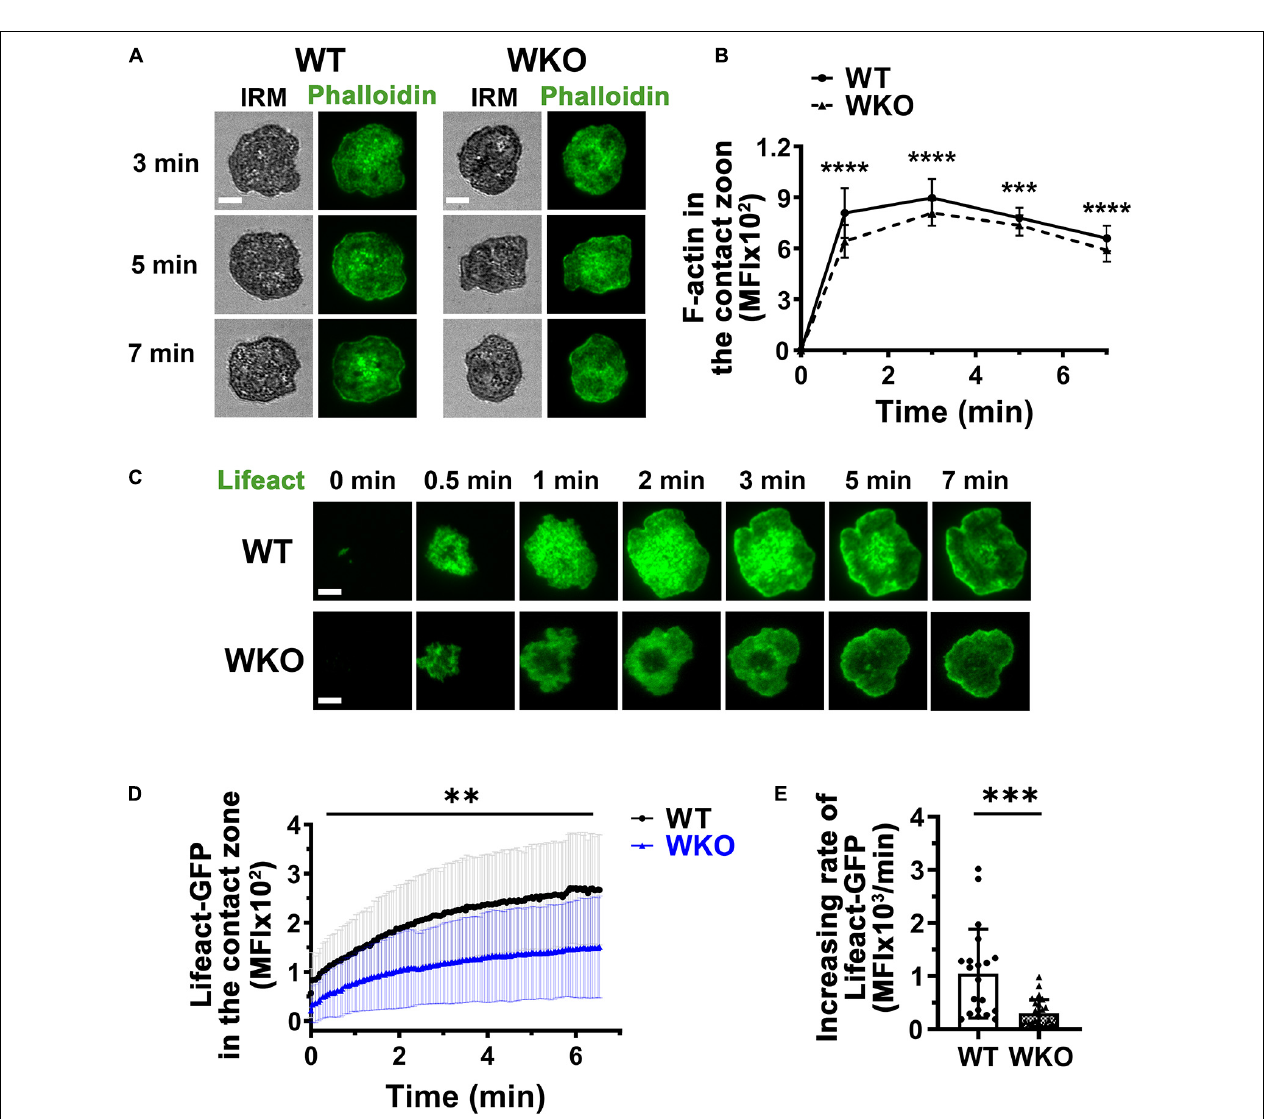
FIGURE 4 | WASp is involved in F-actin accumulation in the GCB contact zone. (A,B) GCBs isolated from SRBC-immunized WT and WKO mice were incubated with Fab’-PLB, fixed, permeabilized, stained for F-actin with phalloidin, and imaged using IRM and TIRF. Shown are representative images (A) and the MFI of phalloidin in the GCB contact zone at different times (B) . (C–E) GCBs isolated from SRBC-immunized WT and WKO mice expressing Lifeact-GFP were incubated with Fab’-PLB and imaged live using TIRF. Shown are representative time-lapse TIRF images of Lifeact-GFP (C) , the MFI of Lifeact-GFP in the contact zone over time (D) , and the increasing rates of Lifeact-GFP MFI, measured as illustrated in Figure 2E . Data points represent individual cells. Scale bars, 3 µ m. The results were the average ( ± SD) of 22 ∼ 50 individual cells per condition. n = 4. ** p < 0.01, *** p < 0.001, and **** p < 0.0001, unpaired Student’s t -test or one-way ANOVA.